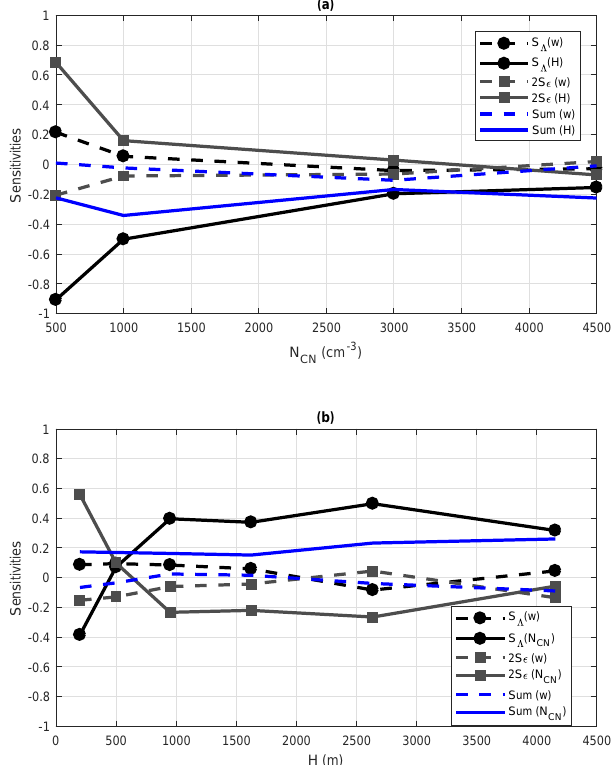
Figure 3. Variations in the sensitivities of (cid:51) and ε with (a) N a and (b) H . Note that the sensitivities of ε are multiplied by 2 in order to be consistent with Eq. (10). The curves are averaged over all values of the third dependent variable. For instance, the curve S (cid:51) (w) in (a) is averaged over all H values. Blue curves represent the sum of the sensitivities of (cid:51) and ε , equivalent to the first two terms on the right-hand side in Eq.